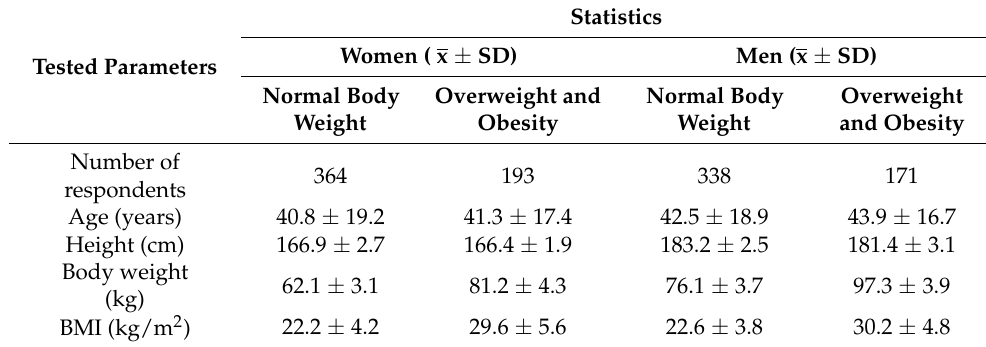
Table 1. Age and morphological parameters of respondents.